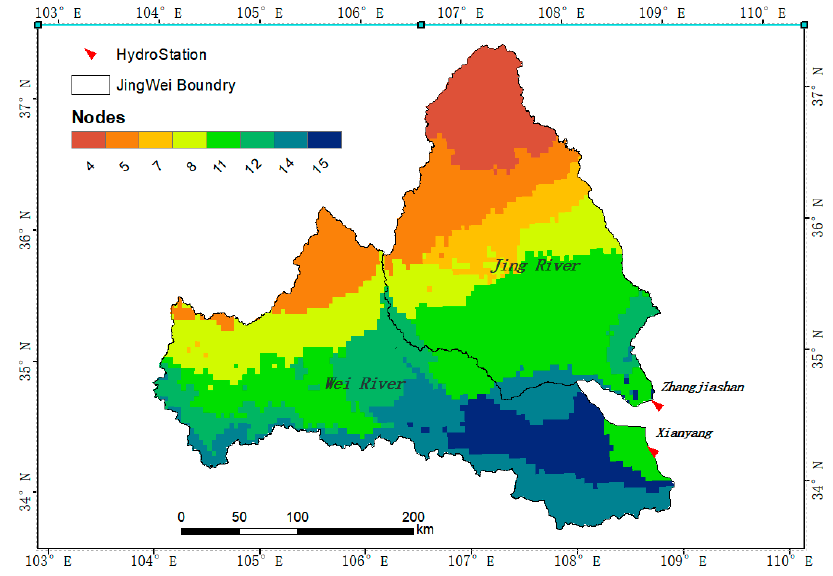
Figure 9. Spatial representation of the nodes’ membership derived from the sensitively analysis.